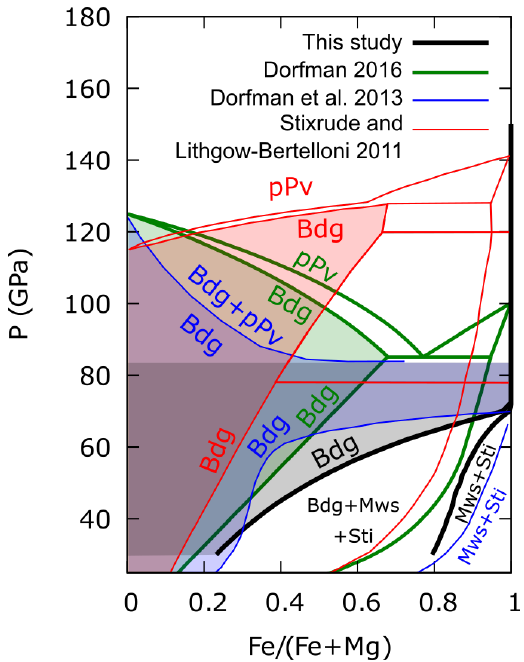
Figure 5. Phase diagram of MgSiO 3 -FeSiO 3 system at ~2000 K based on experimental observations (blue: [19]) and thermodynamic calculations in previous work (red: [46], green: [47]) and this study (bold black lines). Thermodynamic calculations using excess mixing volume term in this study successfully reproduce experimental observations of very high solubility of FeSiO 3 in bridgmanite at deep lower mantle pressures >80 GPa. Regions in pressure-composition space where single phase bridgmanite are stable are highlighted for each phase diagram.